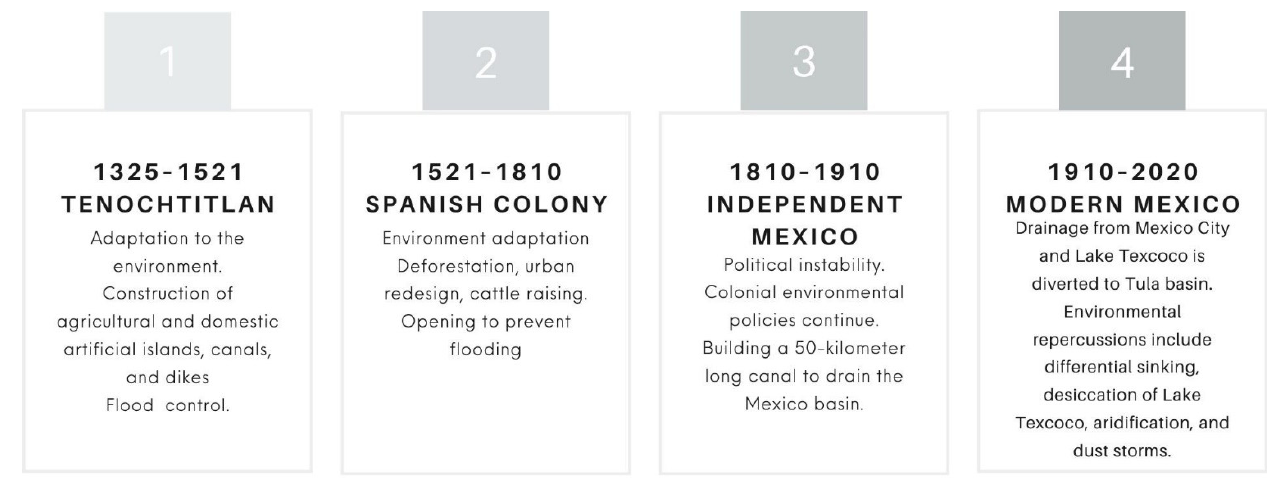
Figure 1. Identified stages for environmental policies in Lake Texcoco history. Author elaboration based on critical moments.